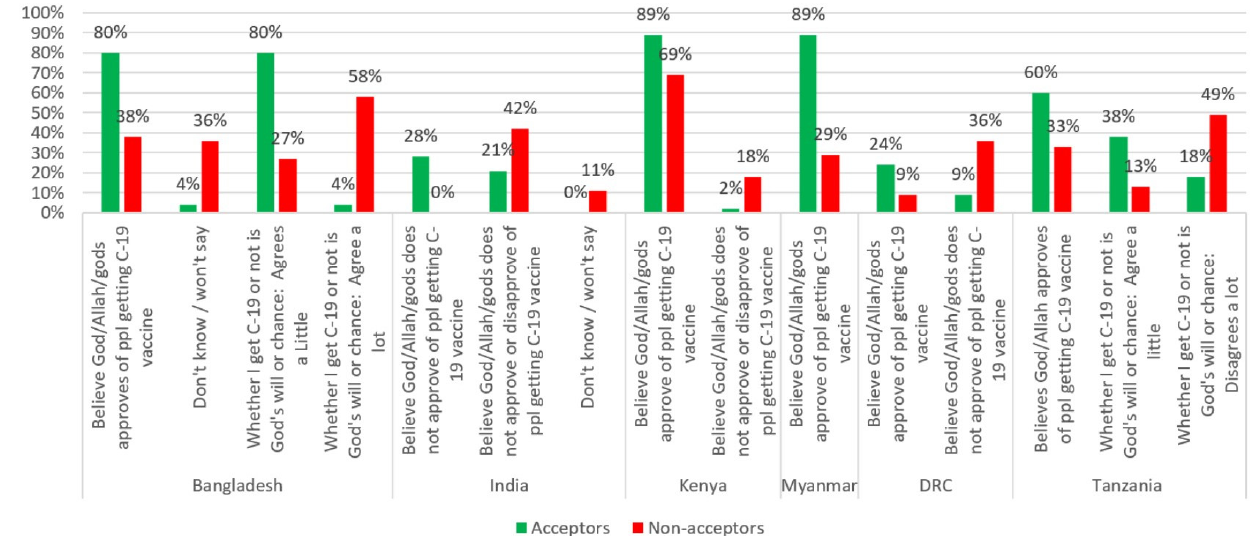
Figure 11. Perceived divine will regarding COVID-19 vaccination by